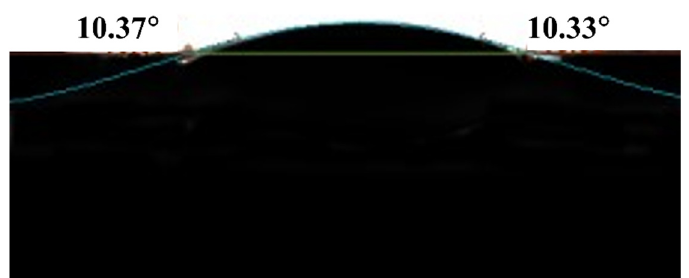
Figure 5. Water contact angle measurement of the HTO/CA.